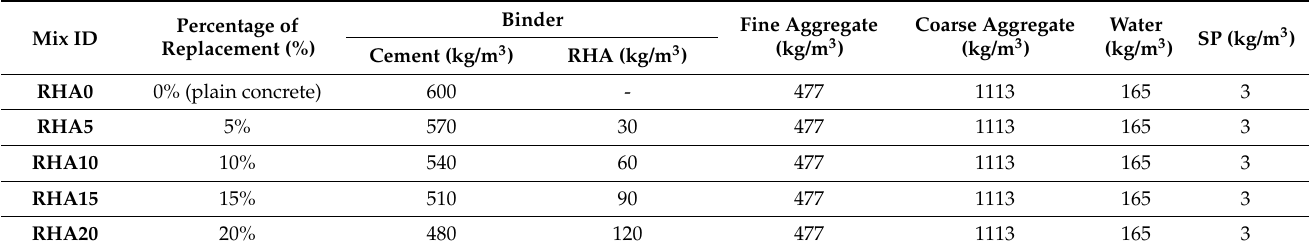
Table 3. Details of mix proportions of